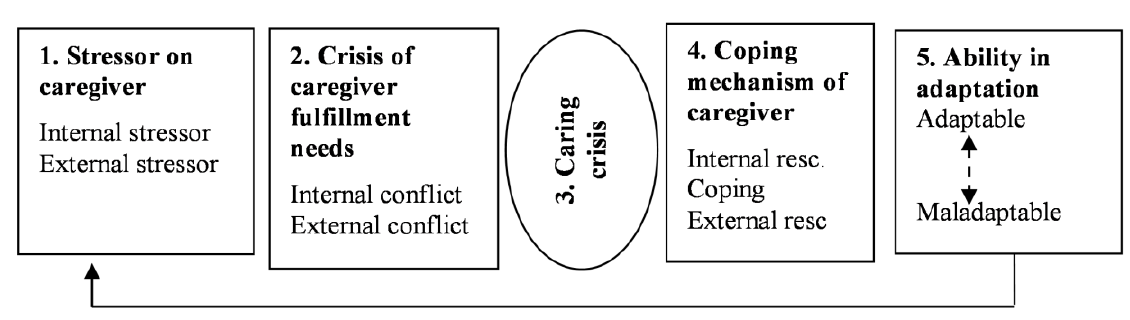
Figure 1 . The themes scheme of stress and adaptation process in breast cancer